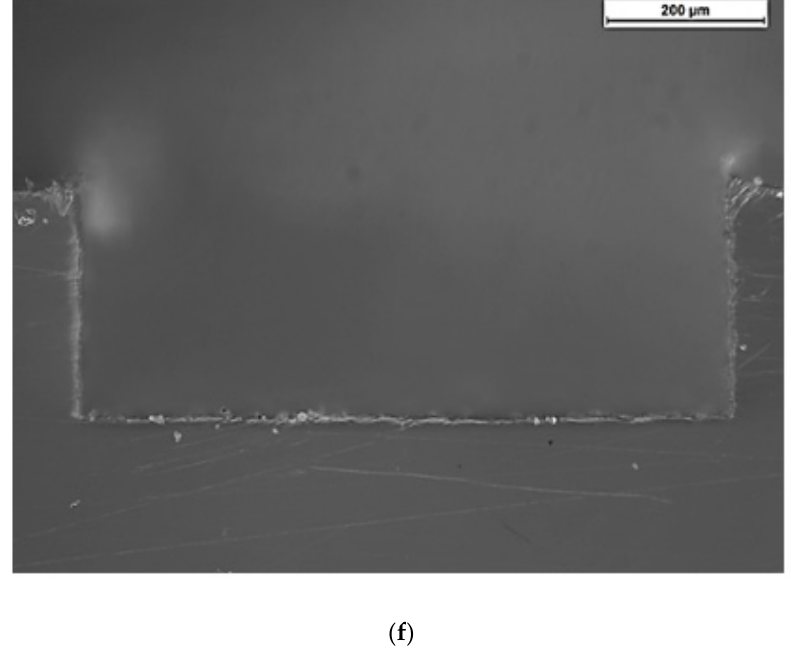
Figure 4. Surface profile and slot images for TiAlN at different feed rates: ( a ) Surface profile at 0.025 mm/rev feed rate. ( b ) Surface profile at 0.075 mm/rev feed-rate. ( c ) Surface profile at 0.10 mm/rev feed-rate. ( d ) Slot image at 0.025 mm/rev feed rate. ( e ) Slot image at 0.075 mm/rev feed rate. ( f ) Slot image at 0.10 mm/rev feed rate.